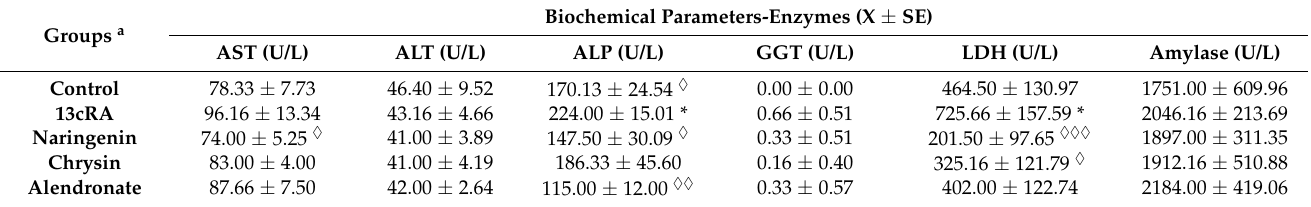
Table 2. Effects of naringenin, chrysin, or alendronate on enzymatic biochemical parameters in blood of rats with retinoic-acid-induced osteoporosis.